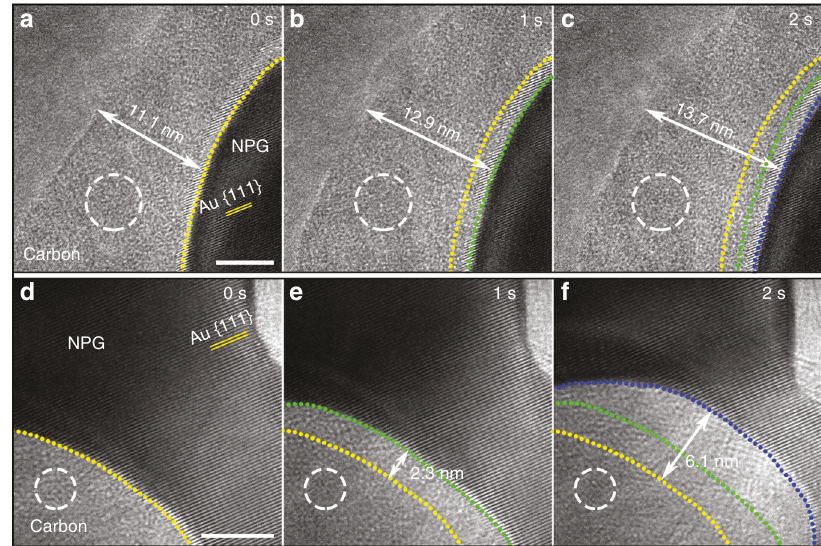
Fig. 2 In situ dynamic process of the catalytic CH 4 pyrolysis reaction on NPG. a – c HRTEM images at three different moments during the reaction on a surface region with positive curvature. The images have the same scale bar. The moment in a is de fi ned as 0 s. The yellow, the green, and the blue dashed lines indicate the positions of the surface at 0, 1, and 2 s, respectively. The white dashed circles denote the positions of a randomly selected carbon region, and the arrows indicate the thickness of the amorphous carbon at 0, 1, and 2 s. d – f have the same meanings as a – c but are for a surface region with negative curvature. The arrows indicate the reduction of the NPG ligament at 0, 1, and 2 s. a – c and d – f are cut from Supplementary Movies 1 and 2, respectively (see more details in “ Methods ” ). Scale bars: a 5 nm; d 5